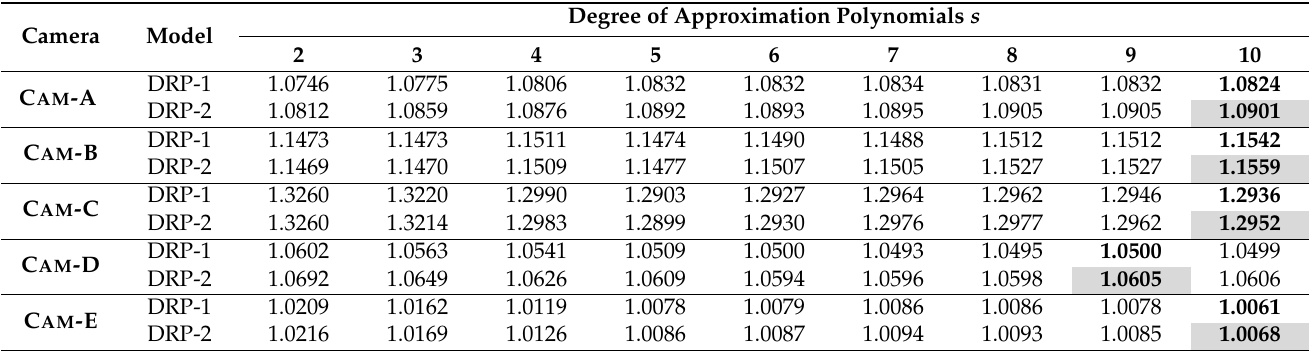
Table 5. Comparison of the obtained η values for the DRP-1 and DRP-2